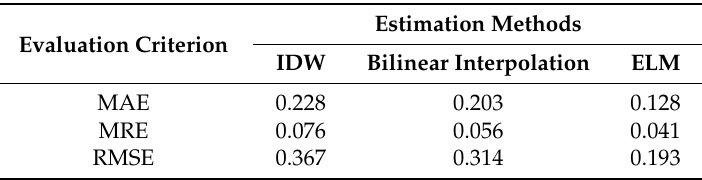
Table 3. Performance of the estimation methods in test Region